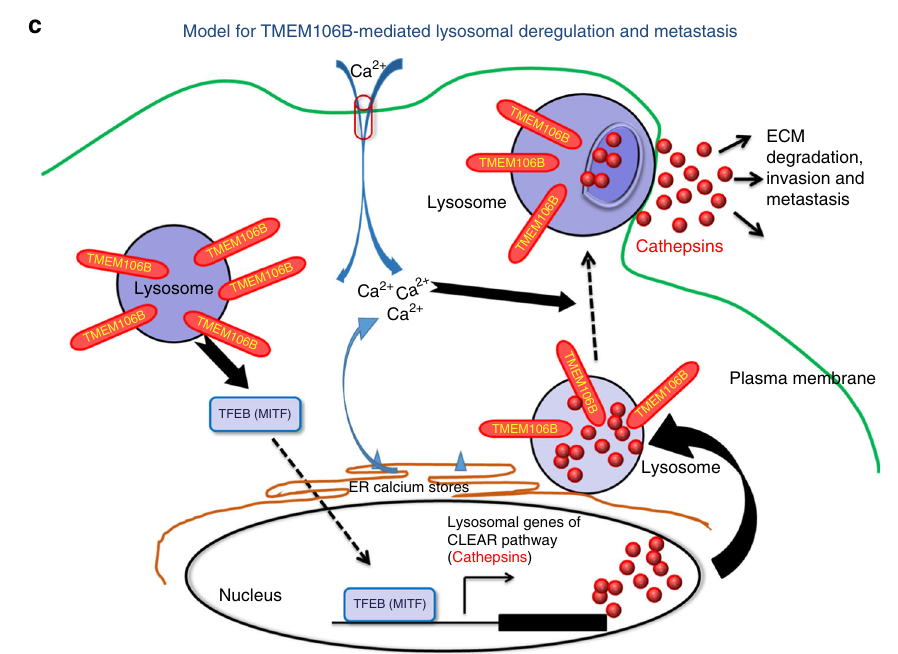
Fig. 9 TMEM106B expression is elevated in human lung adenocarcinomas and predicts for poor prognosis. a Overall survival and b disease-free survival plots of lung adenocarcinoma patents with elevated expression of TMEM106B in TCGA (provisional, n = 517) data set. Graphical representation of respective case numbers and median survivals are shown below. c Schematic of model for TMEM106B -mediated deregulation of lysosomal function in cancer